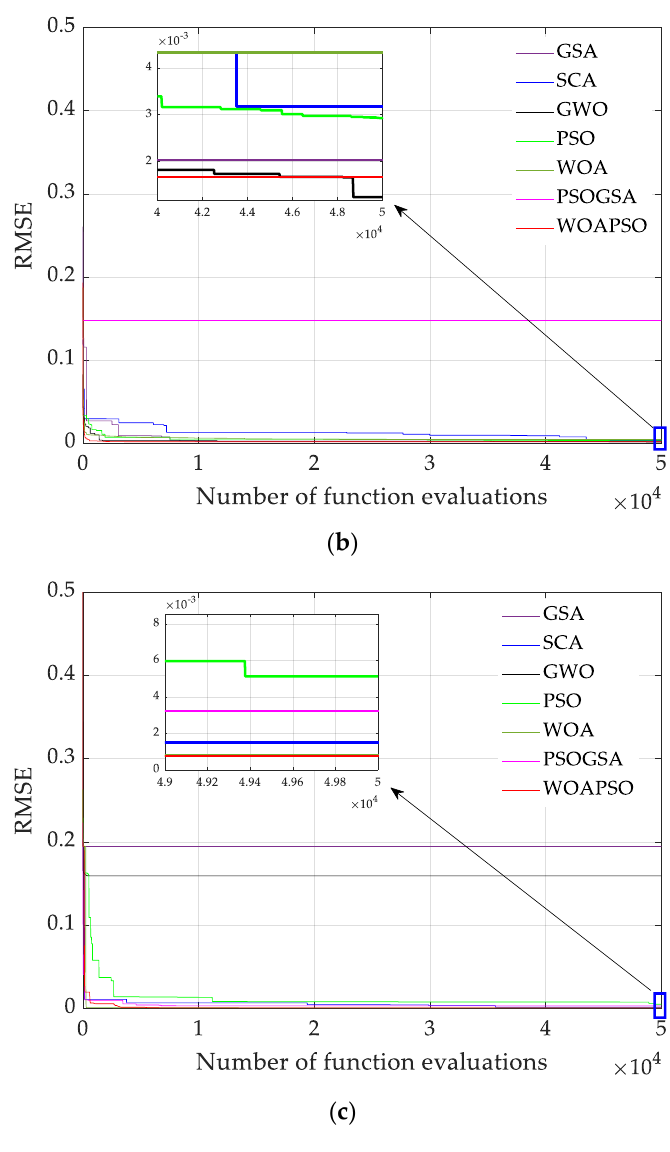
Figure 7. Convergence curve of WOAPSO and other six algorithms for ( a ) single-diode model ( b ) double-diode model of R.T.C France solar cell and ( c ) single-diode model of SS2018P PV